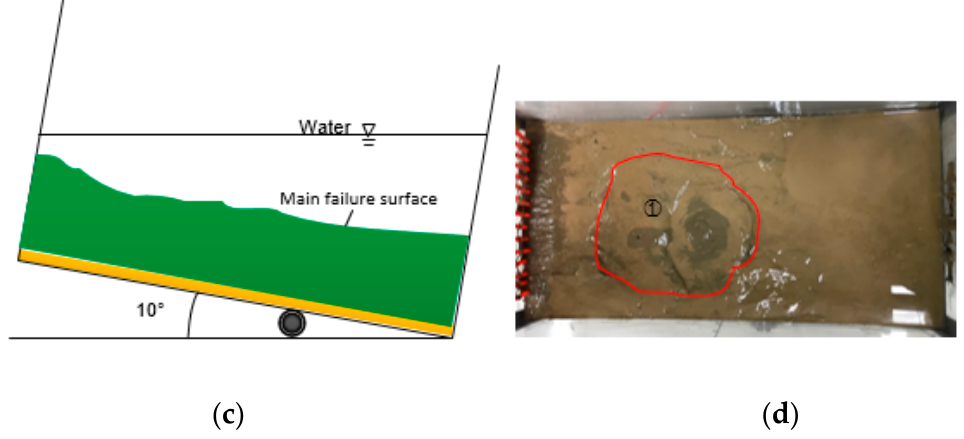
Figure 8. Profile and plan views of the slope after failure in Model 20-10. ( a ) Before Angle adjustment; ( b ) After the Angle adjustment; ( c ) After the destruction; ( d ) top view of end of experiment.